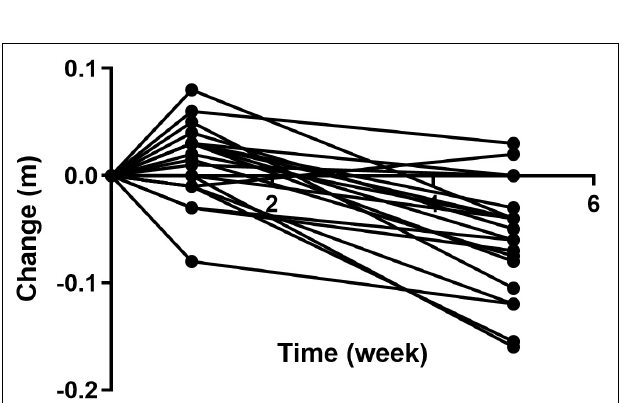
FIGURE 13 | Change in waist circumference of participants throughout the trial as compared to Week 0. Week 1 represents a second measurement after a control week of normal diet. Week 5 represents a third measurement after 4 weeks of a 100% Huel diet.